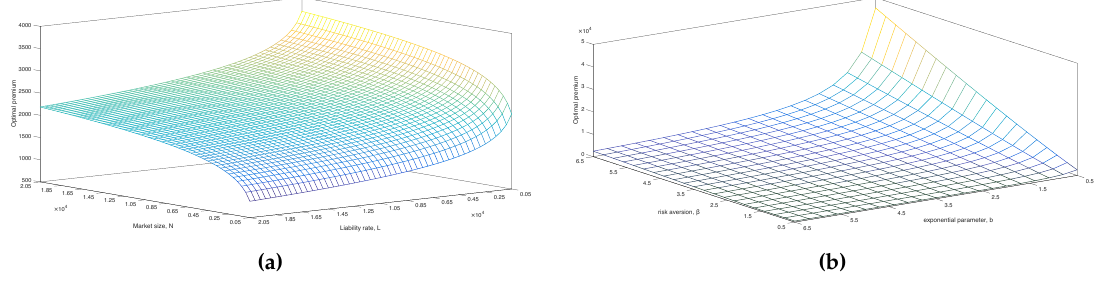
Figure 5. Mesh of the optimal premium max { p ∗ ( 1000 ) , ˜ p ( 1000 ) } for different values of the parameters. If a parameter does not vary, then it has the same value as in previous graphs. ( a ) Mesh of the optimal premium for L , N ∈ [ 500,20500 ] ; ( b ) mesh of the optimal premium for β , b ∈ [ 0.5,6.5 ]